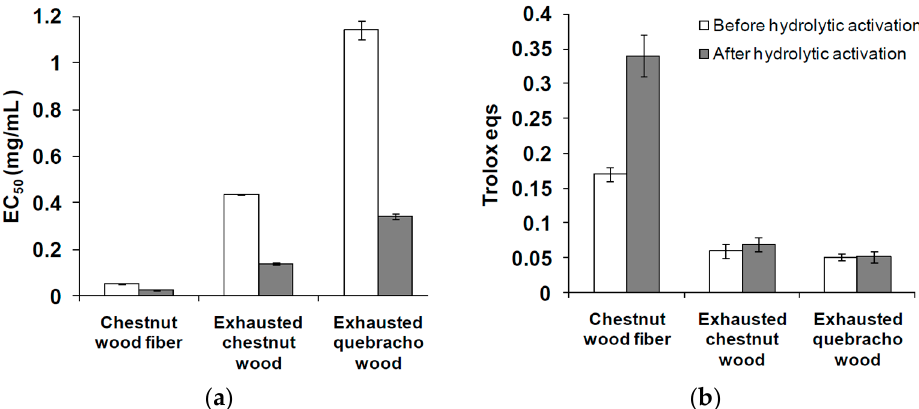
Figure 5. Antioxidant properties of exhausted wood samples before and after hydrolytic activation. ( a ) DPPH assay; ( b ) ferric reducing / antioxidant power (FRAP) assay. Reported are the mean ± SD values of at least three experiments.